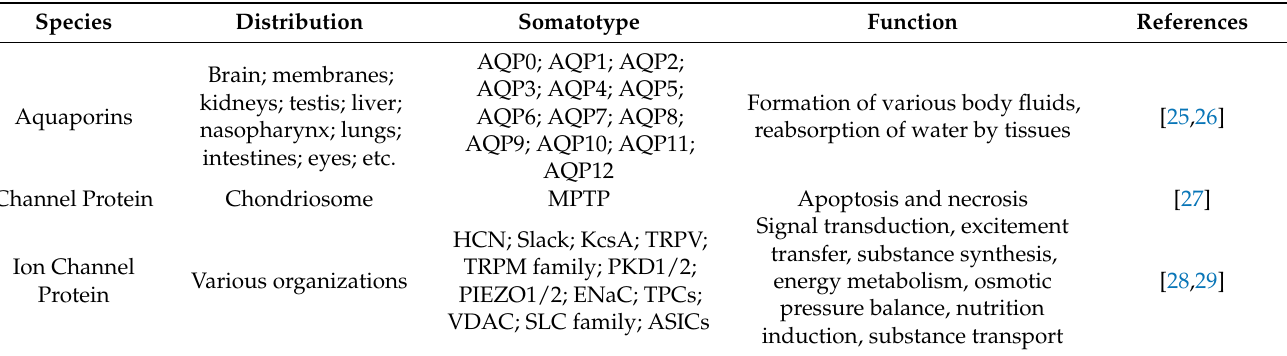
Table 2. Classification of membrane channel proteins.